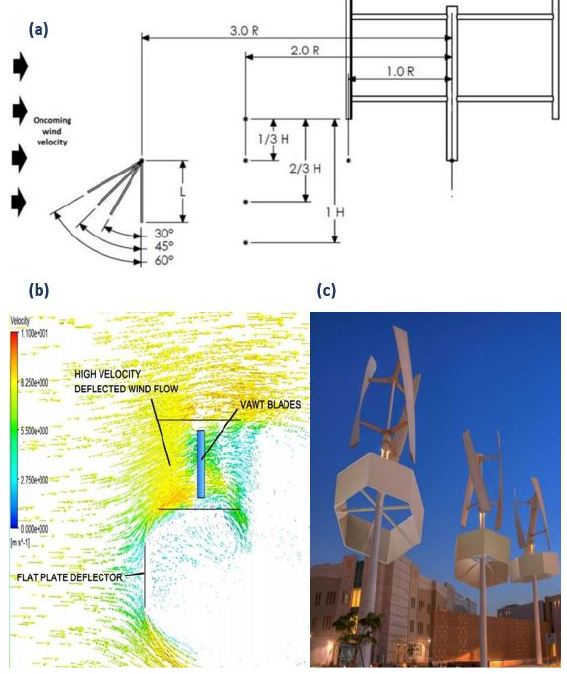
Figure 9. Flat-plate wind deflector in helical vertical axis turbine. ( a ) Design. ( b ) CFD analysis. ( c ) Installed deflector (adapted from [78]) .